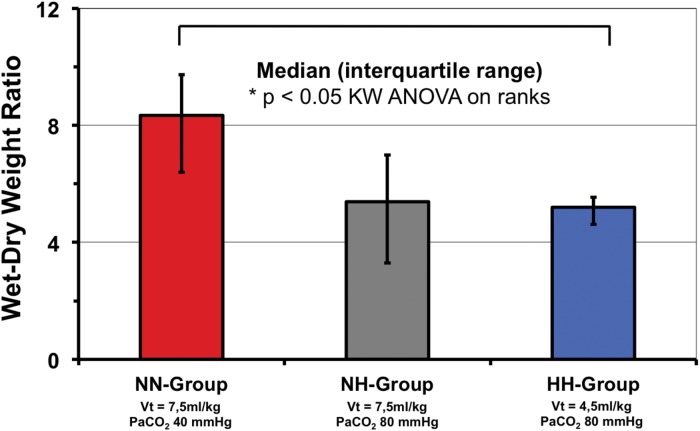
Wet-dry-weight ratio of excised lungs.* = p< 0.05. NN vs. NH groups: p = 0.07.